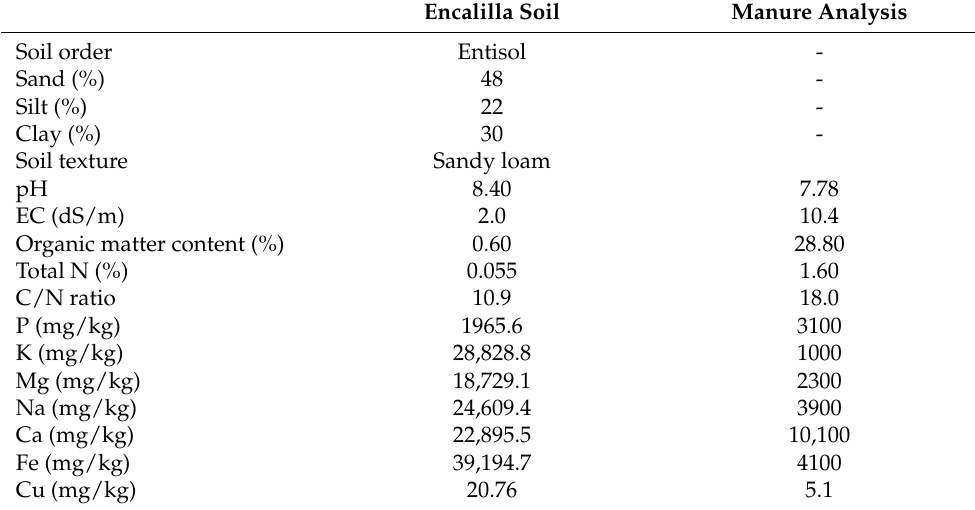
Table 1. Soil and manure